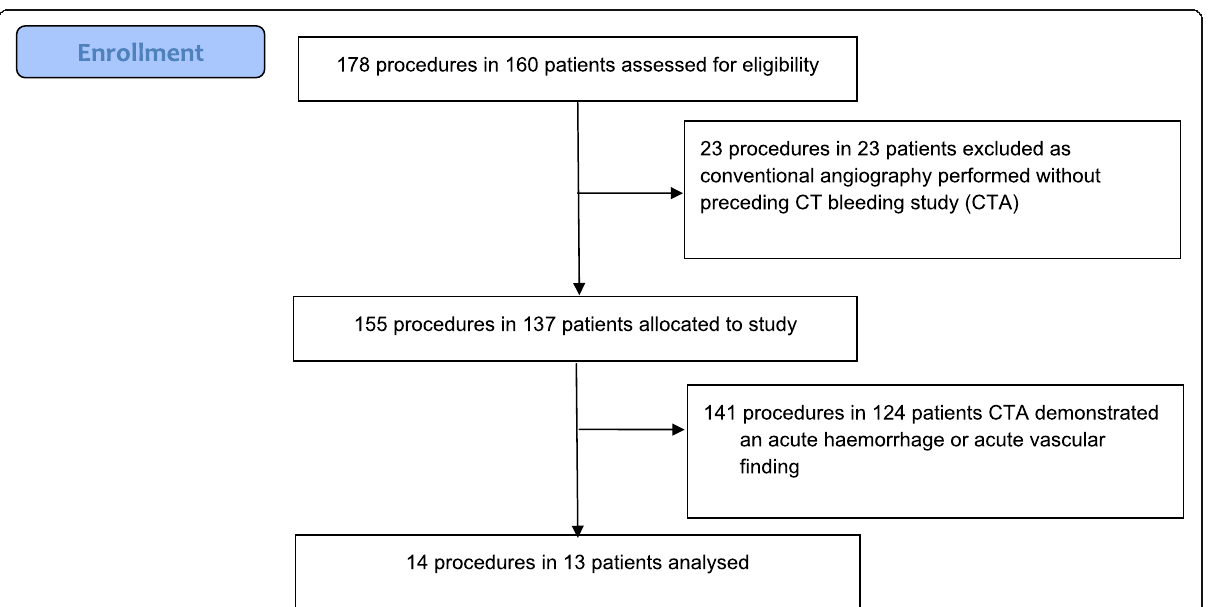
Fig. 2 Flow diagram of patients with hemodynamic instability who underwent conventional angiography (CA) procedures for acute abdominal arterial hemorrhage during the